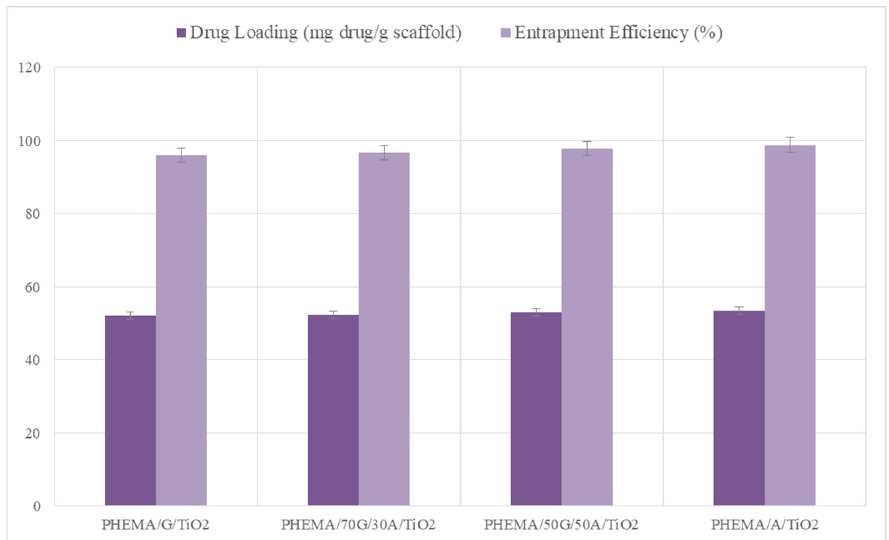
Figure 8. Drug loading and entrapment efficiency of PHEMA/G/TiO 2, PHEMA/70G/30A/TiO 2 , PHEMA/50G/50A/TiO 2, PHEMA/A/TiO 2 hybrids.